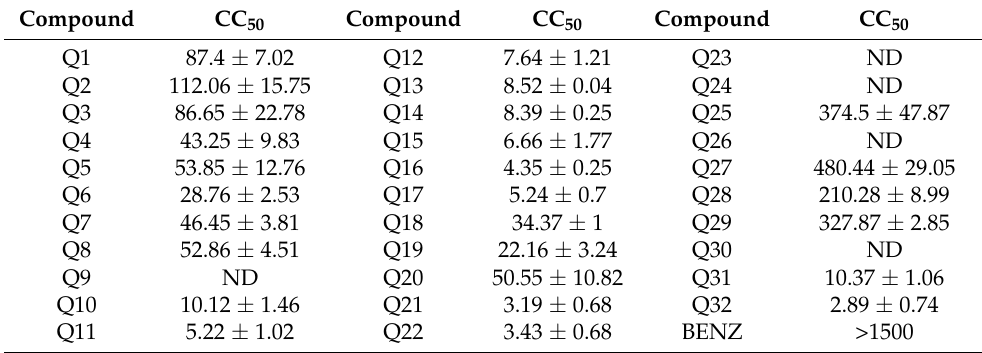
Table 2. Cytotoxicity of the tested acrylonitriles against murine macrophages (data are shown in µ M). CC: cytotoxic concentration. ND: not determined.